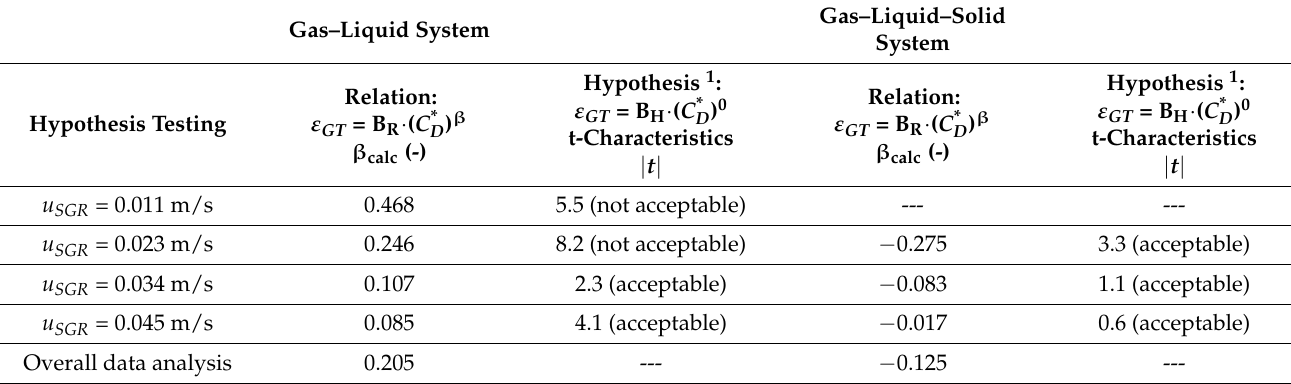
Table 8. Total gas holdup ε GT : Results of the hypothesis testing-effect of deflector clearance C D on superficial gas velocity u SGR = const.